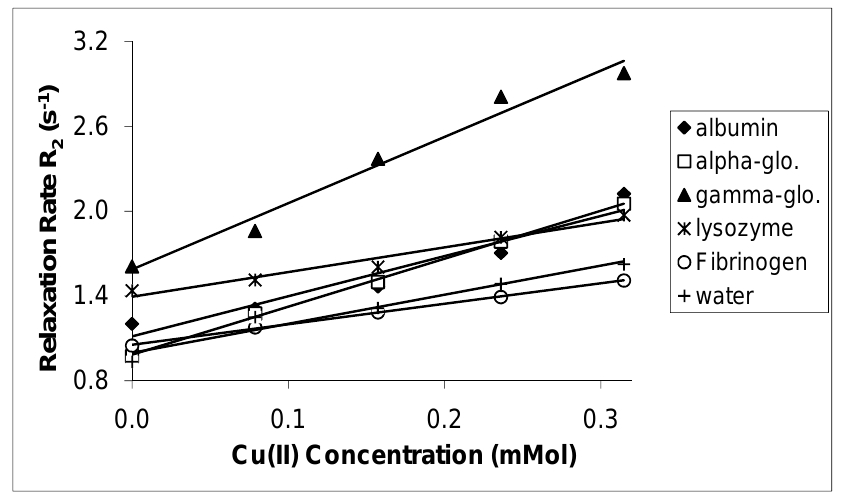
Figure 5. The Spin-Spin Relaxation rates (R